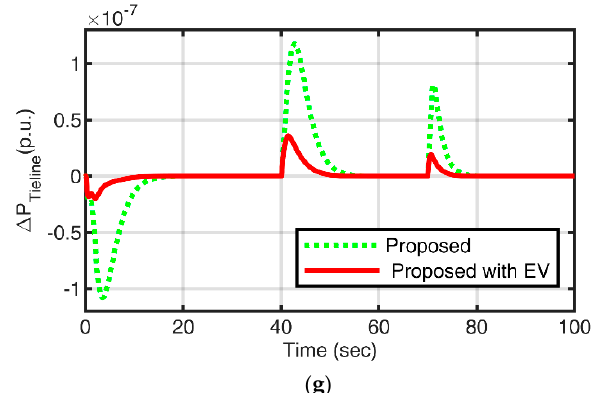
Figure 9. ( a ) Step variation in load, wind speed, and solar irradiance. ( b ) Frequency response of area 1 with fuzzy-PI-PDF controller. ( c ) Frequency response of area 2 with fuzzy-PI-PDF controller. ( d ) Tie-line Power of area 1 with fuzzy-PI-PDF controller. ( e ) Frequency response of area 1 with the proposed controller with and without EVs. ( f ) Frequency response of area 2 with the proposed controller with and without EVs. ( g ) Tie-Line power with the proposed controller with and without EVs. Table 3. Performance indices with step load